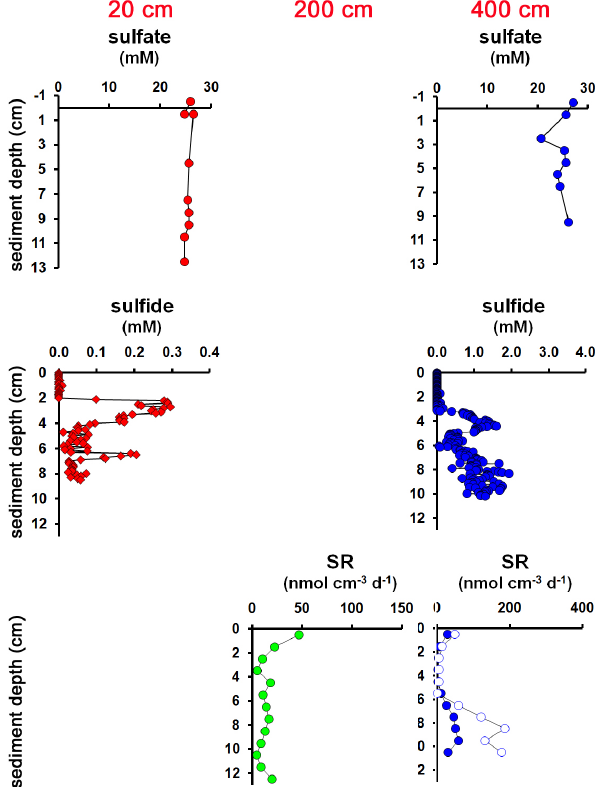
Fig. 1c. Biogeochemical profiles of the April sampling (transect) at Brian Seep: sulfate, sulfide, and sulfate reduction (SR, 2 repli- cates). Samples were available from 20 (red), 200 (green), and 400cm (blue) distance from the gas vent.